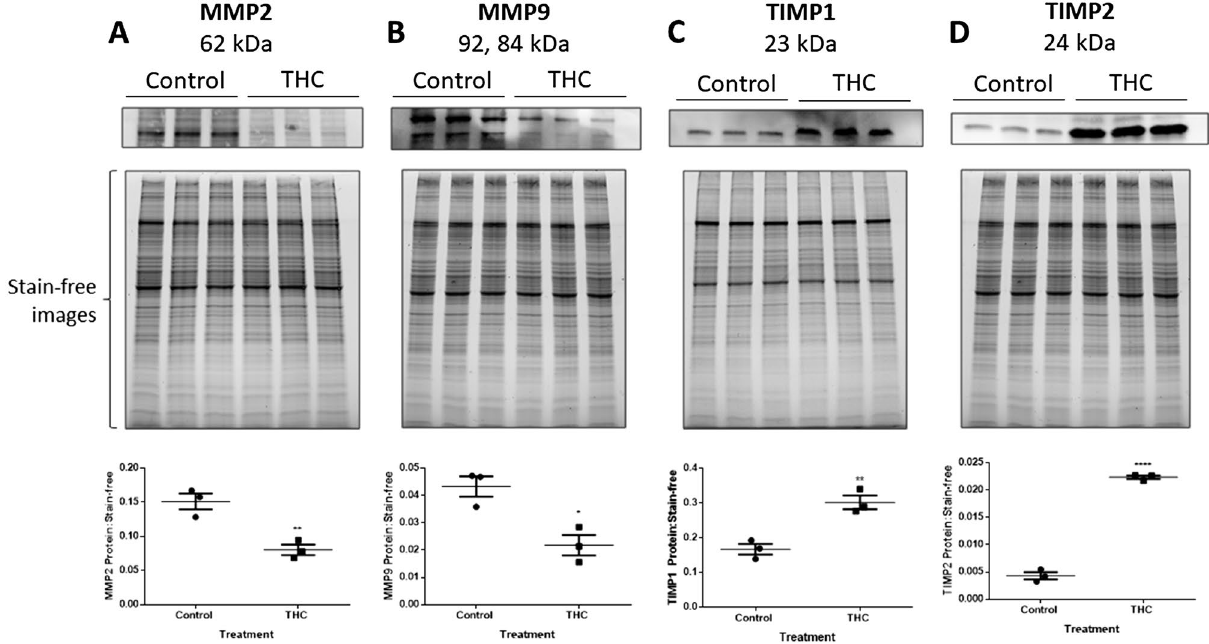
Figure 3. THC alters the expression of MMP and TIMP proteins in HTR8/SVneo cells. (A–D) Total protein was isolated from HTR8/SVneo cells and analyzed by Western blot (20 µg). Summary histograms of active MMP2 (A) , pro-MMP9 and active MMP9 (B) , TIMP1 (C) , and TIMP2 (D) of relative band density in each treatment group normalized to stain-free image are shown below the Western blot images. Significant differences were determined by Student’s t-test. The individual points represent the ratios of proteins (n = 3), the horizontal lines represent the means and the error bars represent SEM. ** P < 0.01 (A,C) , * P < 0.05 (B) , **** P < 0.0001 (D)